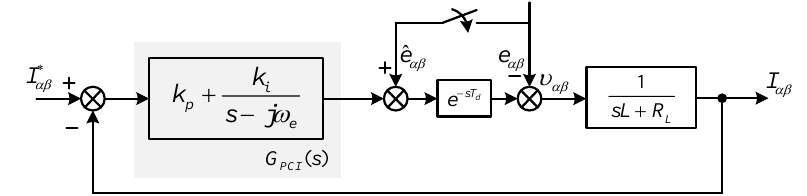
Figure 3. The diagram of PCI-based current closed-loop for GC-VSCs.